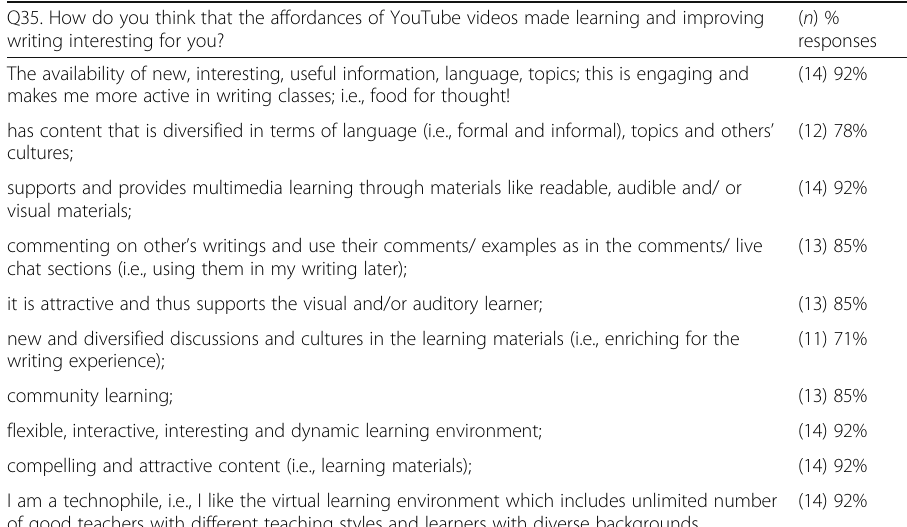
Table 10 Learners ’ perspectives on how YouTube affordances made learning and improving writing